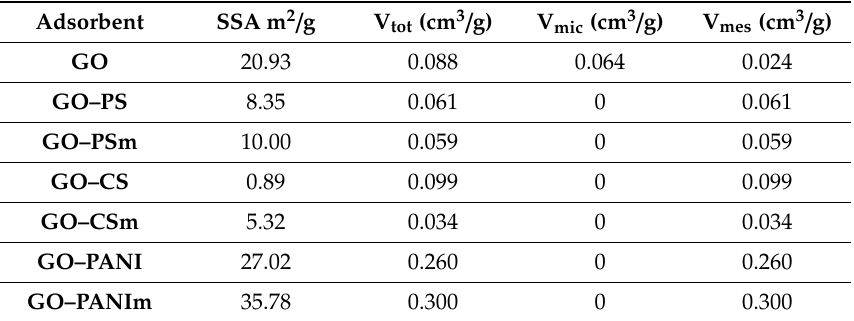
Table 1. Textural parameters for the graphite oxide (GO)-polymers composites.